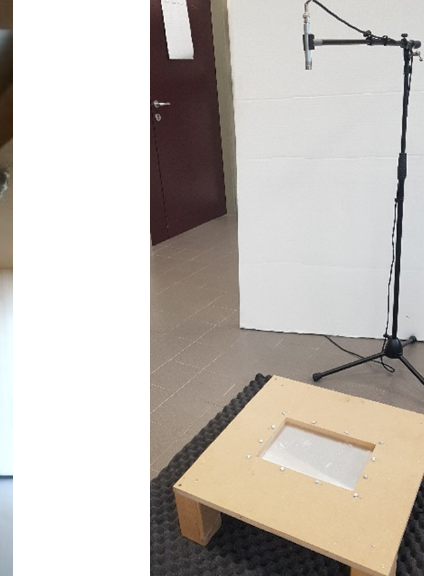
Figure 2. ( a ) B&K shaker type 4810 connected to the plate via a stinger. The PCB load cell is visible at the top of the shaker. ( b ) Acoustic measurement of the plate with a B&K microphone at 1 m on- axis.